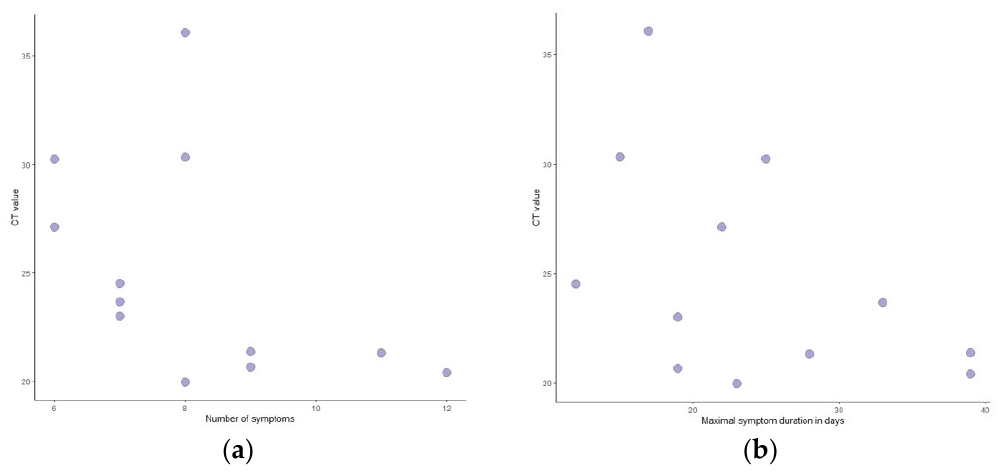
Figure 7. Ct values relative to number of symptoms ( a ) and duration of symptoms ( b ).